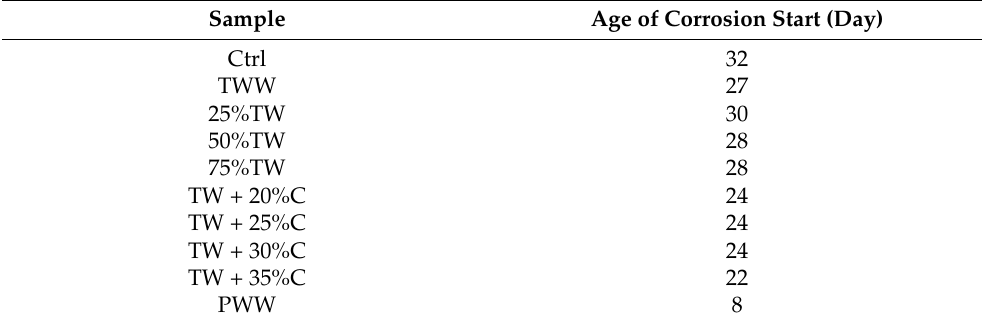
Table 9. The start age of armature corrosion.